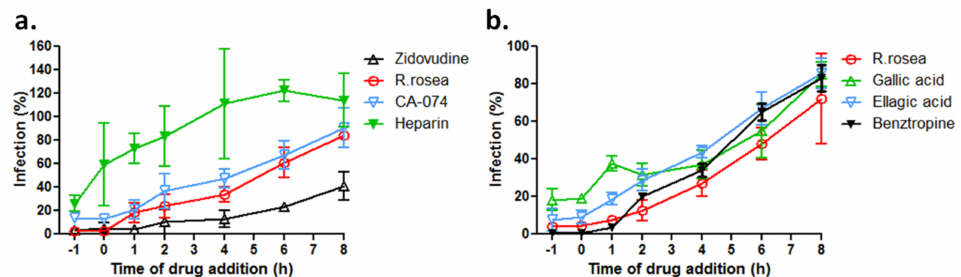
Figure 5. R. rosea extract, ellagic acid and gallic acid inhibit EBOV infection at late entry step. Pseudotyped HIV/EOBV was incubated with A549 cells at 4 ◦ C at the − 1 h time point. After 1 h of incubation, the virus was removed and temperature was shifted to 37 ◦ C to trigger virus internalization. ( a ) R. rosea extract (4 µ g/mL), heparin (10 µ g/mL), zidovudine (2 µ M), CA-074 (100 µ M) were introduced at different time points of virus infection, and the compounds’ effects on viral infection are shown (means ± SD ( n = 3)); ( b ) R. rosea extract (4 µ g/mL), gallic acid (30 µ M), ellagic acid (30 µ M), and benztropine (25 µ M) were introduced at different time points of virus infection, and the compounds’ effects on viral infection are shown (means ± SD ( n =